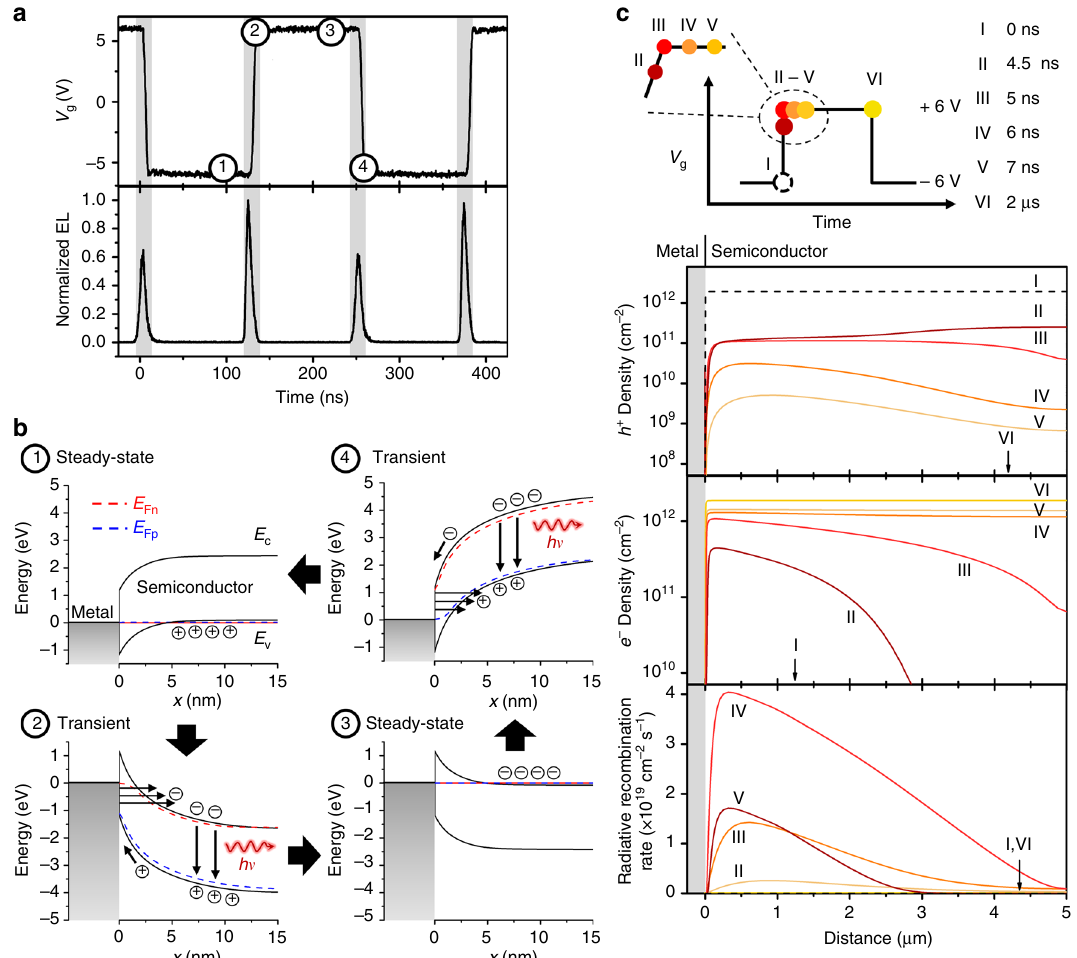
Fig. 2 Operation mechanism. a Time-resolved electroluminescence and the corresponding V g , showing that EL occurs at the V g transients (time points 2 and 4). b Band diagrams at different times during the operation cycle, corresponding to a . E Fn and E Fp indicate the quasi-Fermi levels for electrons and holes, respectively. c V g pulse applied to the simulated device and the corresponding electron/hole density and radiative recombination rate. Simulations were performed for material parameters corresponding to WSe 2 using a 50 nm thick gate oxide and V g = ± 6 V (simulated band diagrams are also shown in Supplementary Figs. 5 and Supplementary Fig. 2 (the operation mechanism is also depicted in Supplementary Video 1). Pulsed EL is observed at each V g transition and has a full-width half-maximum of 8 ns. EL emis- sion in the device increases linearly with frequency ( f ) as shown in Supplementary Fig. 3 and Supplementary Note 2, with no changes in spectral shape. Note that the EL is stable with an approximately ±25%) intensity variation over time (Supplemen- tary Fig. 4). The emission mechanism can be elucidated from the sequence of energy band diagrams (simulated via Sentaurus TCAD) shown in Fig. 2b, Supplementary Figs. 5 and 6 as well as the carrier densities and radiative recombination rate shown in Fig. 2c. When V g is held at − 6 V, the hole density in the semi- conductor is large and approaches its steady-state value ( p 0 ~1.9 × − 2 ). When V g is switched to + 6 V, the fi eld across the 10 12 cm capacitive component of the device (i.e., SiO 2 gate dielectric) cannot change instantaneously. As a result, the applied voltage is dropped across the resistive parts of the device including the semiconductor and the source contact, but is dominated by the latter. The large voltage drop and the steep energy band bending at the Schottky contact lead to large transient tunneling currents.